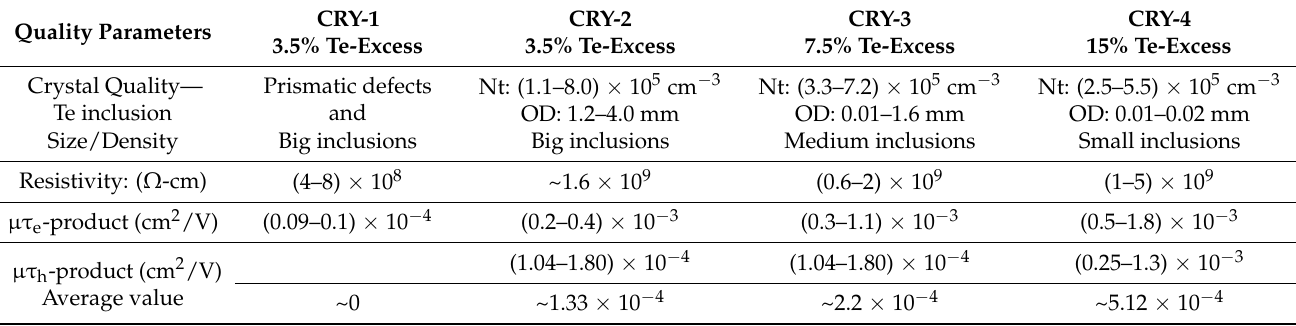
Table 2. Summary of results for CdTe:Cl growths. N t is volumetric density, OD is outer diameter.